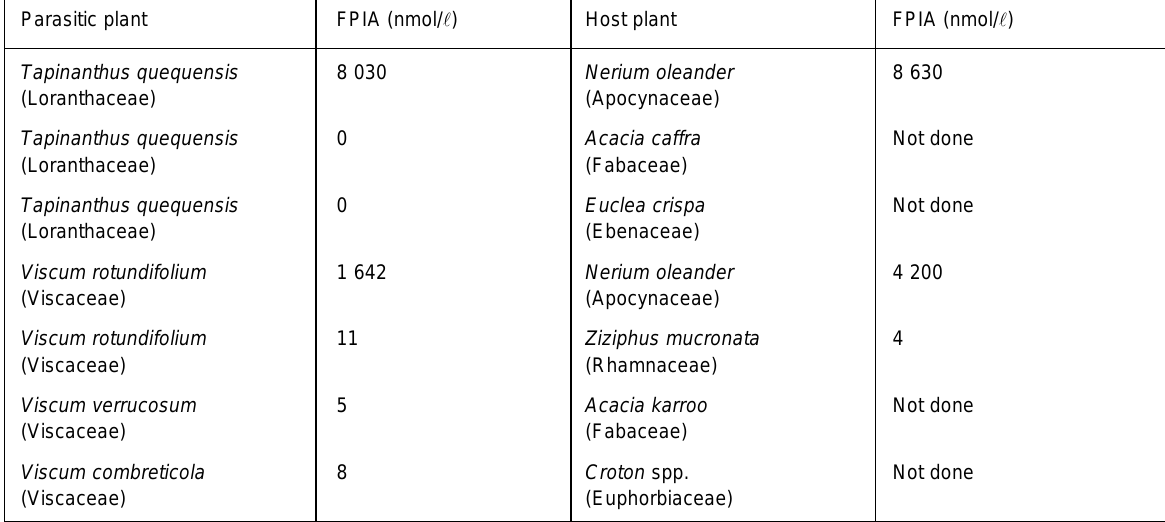
TABLE 4 FPIA values in plants parasitic on cardenolide-containing plants and plants not known to contain cardiac glycosides Parasitic